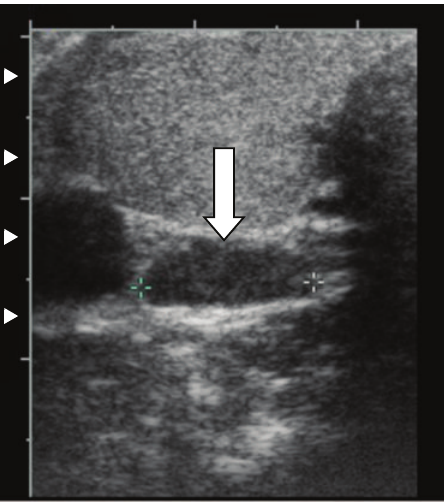
Figure 1: Ultrasound image demonstrates a hypoechoic mass, 1.9 × 0.4 × 1cm, inferior and posterior to the right lobe of the thyroid, consistent an enlarged right inferior parathyroid gland.